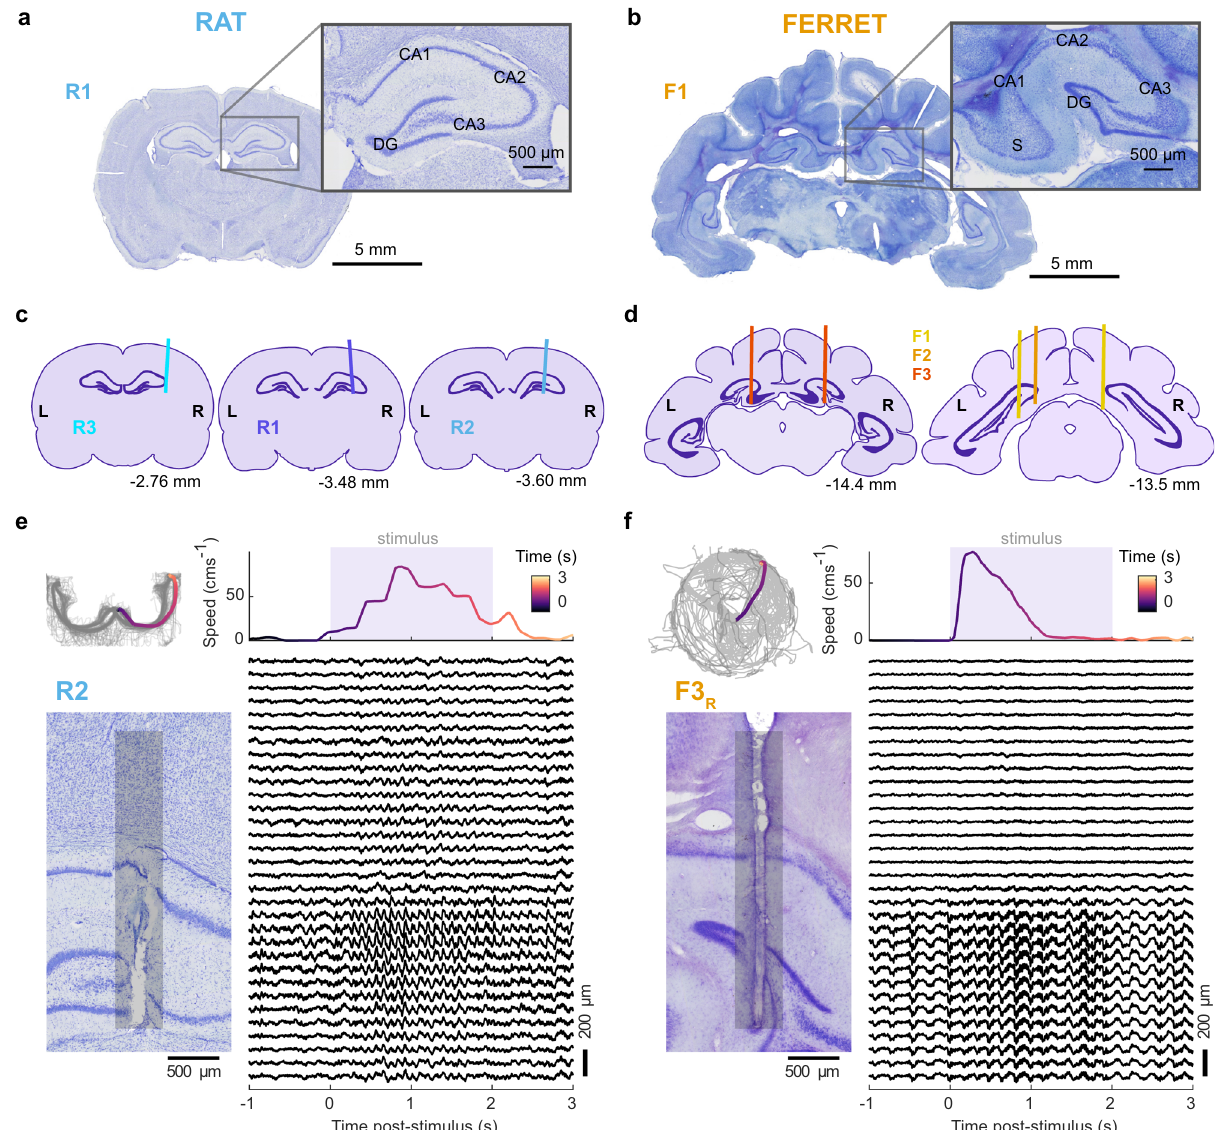
Fig. 2 | Hippocampal formation and electrode position across species. Nissl- stained coronal sections from rat ( a − 3.12 relative to Bregma) and ferret ( b − 14.4mm relative to occipital crest) brain. Insets show magni fi ed images of the dorsalpoleofthehippocampalformation(CA:cornuammonis,DG:dentategyrus, S:subiculum).Estimatedelectrodeimplant locations foreach rat ( c )and ferret ( d ). Brain section outlines were generated from the Rat Brain Atlas 107 and the Ferret BrainAtlas 108 .Left(L)andright(R)hemispheresareindicatedforeachsection.The leftsectionismostanterior;theanterior-posteriorpositionofthesectionisgivenin millimetres relative to bregma (rat) or the occipital crest (ferret). Single-trial